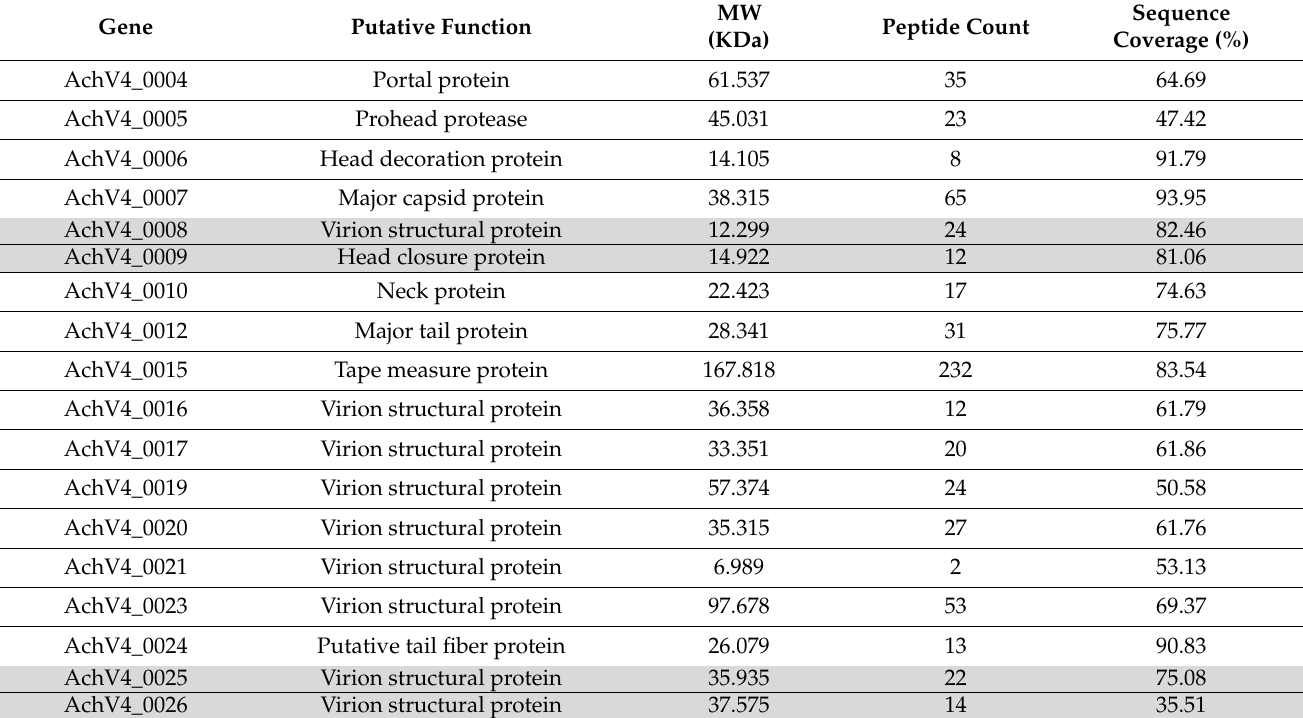
Table 1. Structural AchV4 proteins identified by